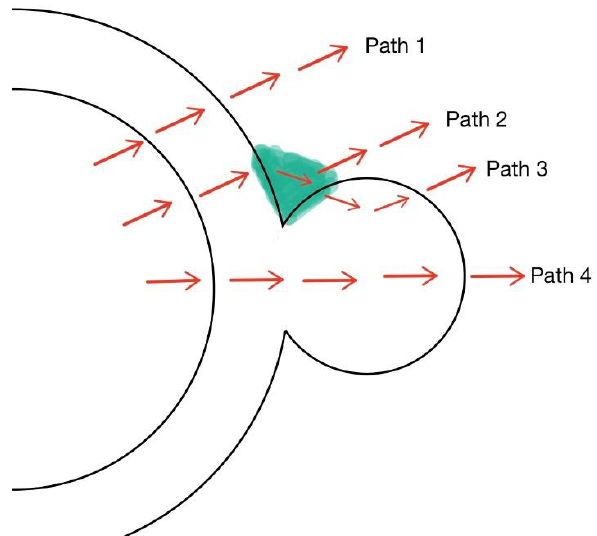
Figure 11. Potential paths of heat fluxes.